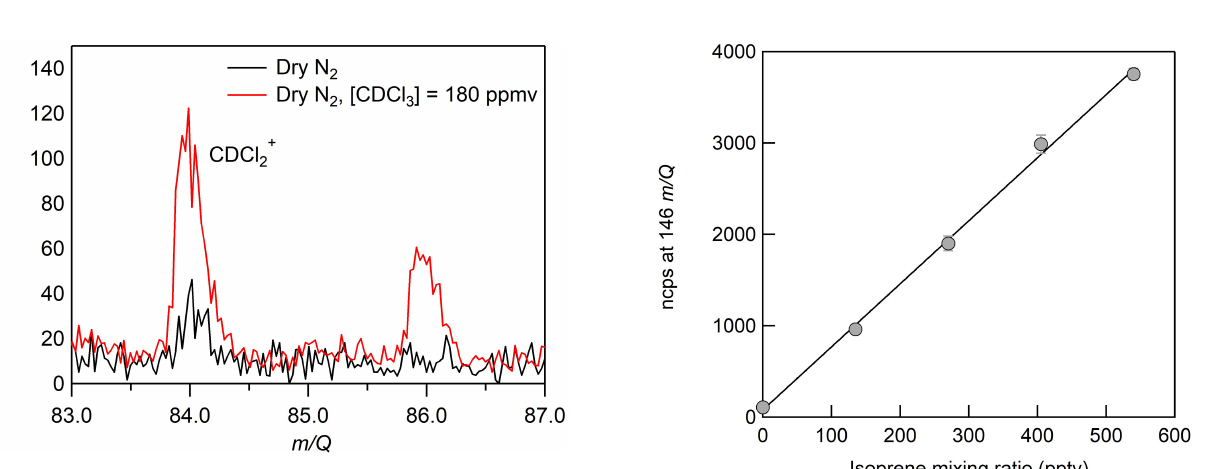
Figure 2. CI-ToFMS mass spectrum acquired when overflowing the inlet with excess nitrogen (black) and for a nebulized solution of chloroform- d at a flow rate of 3µLmin − 1 in a nitrogen carrier gas (red), where the resulting [CDCl 3 ] = 180 ppmv. No signal was observed above the baseline for any other fragments or the parent (CDCl + , 120 m/Q ). 3